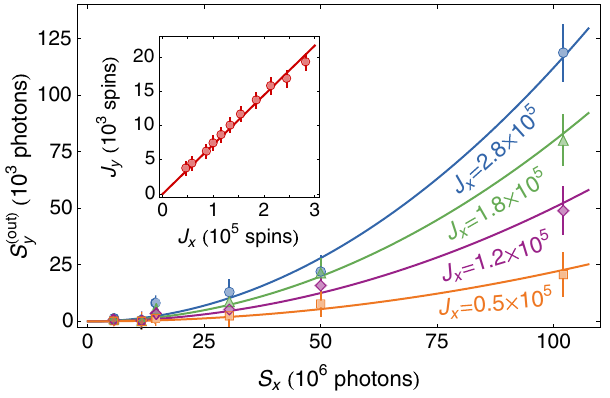
FIG. 2. Alignment-to-orientation conversion measurement of J y . In the main frame, we plot the signal S y ¼ h of the AOC measurement as a function of S x for various J x . We find the measured signal J y from fit to data using the function S y ¼ ð κ 1 κ 2 = 2 Þ J y S 2 x (solid lines). Error bars represent (cid:1) 1 σ statistical errors. Inset: Measured J rotation angles, J y ≃ 2 ω L B z tJ x